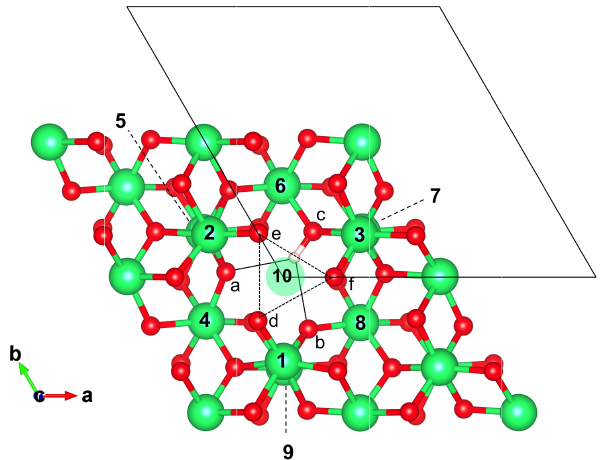
Figure 2. Structure of the singly protonated Al vacancy ( ( 1H + ) Al , Oc ) viewed along the [001] direction. Related models (Table 1) have been obtained by substituting tetravalent cations for Al 3 + in nearby sites. The surrounding Al sites are labeled from 1 to 10, and the oxygen sites are labeled from a to f. Note that the Al site 10 corresponds to the octahedral site belonging to the same pair as the vacant site, while sites 1, 2 and 3 belong to the same octahe- dral layer as the vacant site. The small oxygen triangle (e, f, d) is represented by the dotted lines. The OH group is nearly parallel to the (001) plane and shares a bifurcated hydrogen bond (plain lines) with the facing a and b oxygen atoms. Al, O and H atoms are in green, red and light pink, respectively.